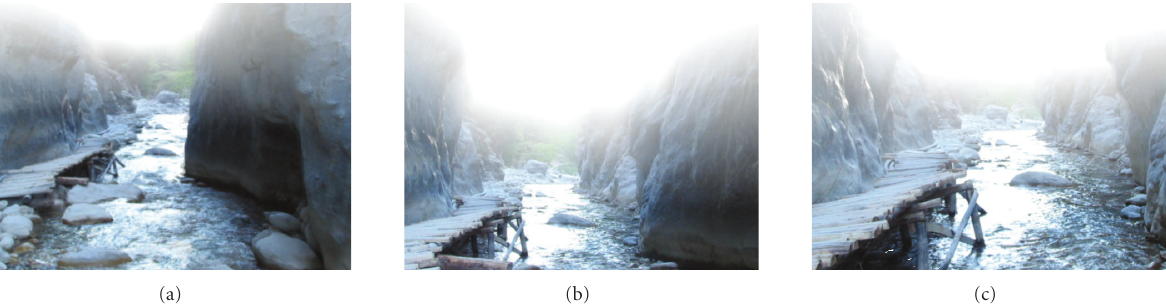
Figure 13: One of the additional benefits of having a virtual 3D reconstruction of the gorge is the ability, for example, to add synthetic visual e ff ects. Here, for instance, a synthetically generated volumetric fog has been added to the scene.